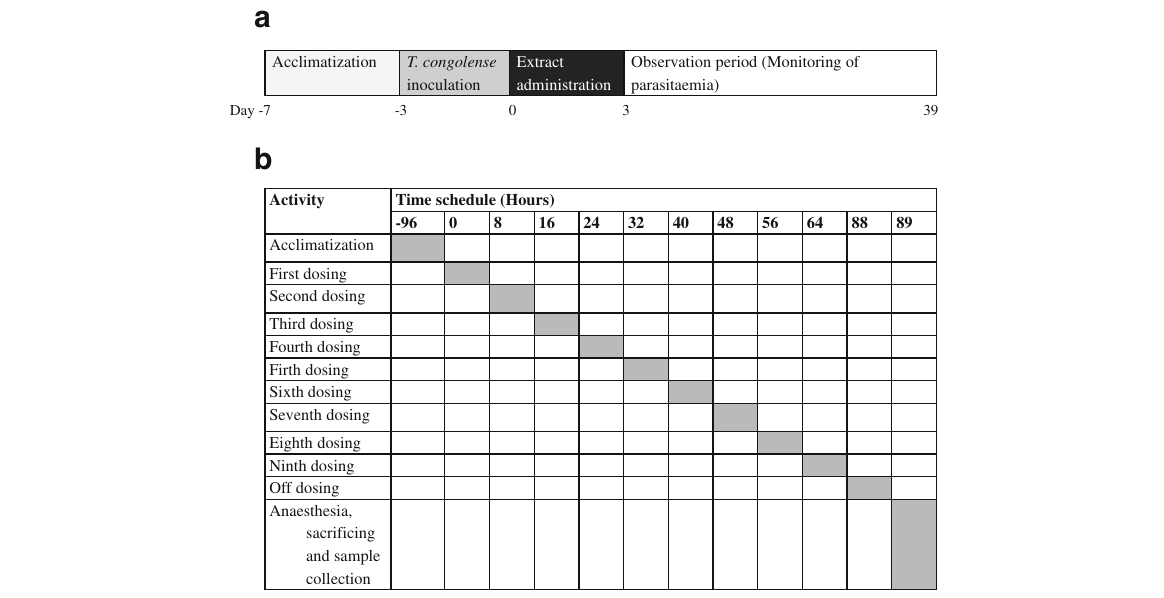
Fig. 1 Experimental timeline, a Timeline trend of major events for the experiment that was assessing the in vivo activity of C. swynnertonii extract on the parasitaemia of T. congolense in mice. b Timeline schedule extract administration for the experiment that was assessing the effect of C. swynnertonii extract on some immunological components in